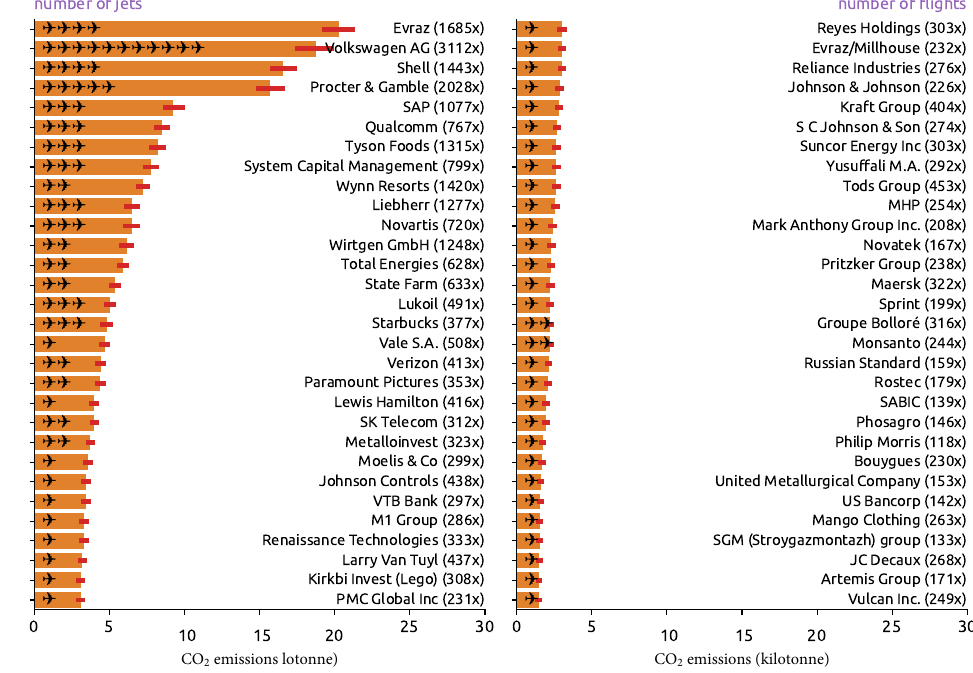
Figure 7. Flight CO 2 emissions associated with companies. Emissions statistics overlap with jets from executives in Figure